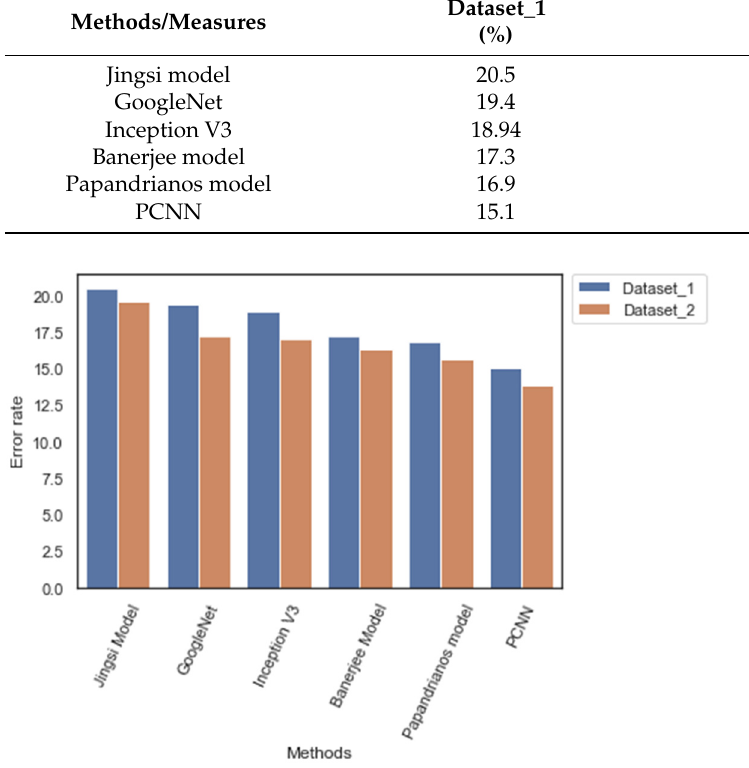
Figure 13. Error rates of CNN models.